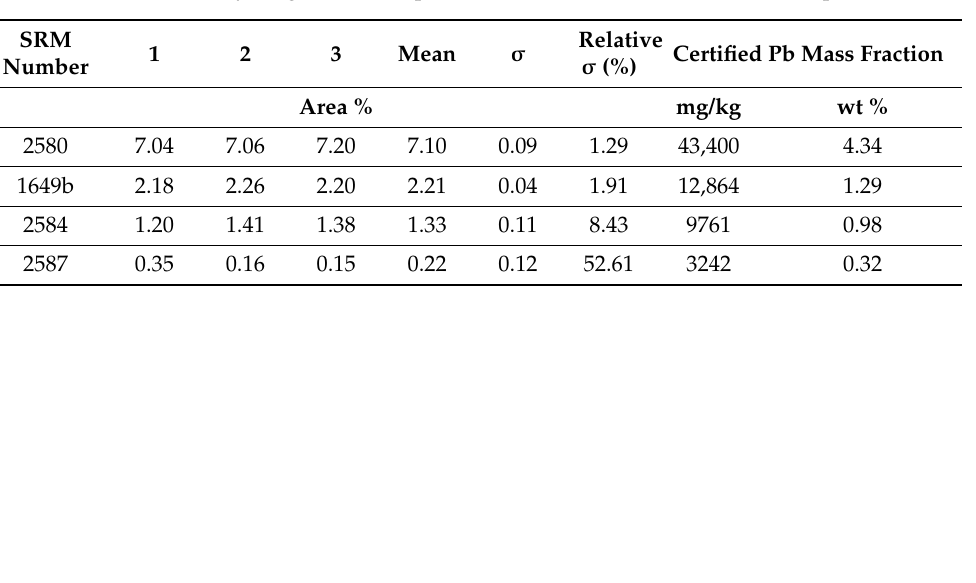
Table 3. Summarised PARC results for NIST SRMs, showing Pb-rich phase abundance as silhouette area fraction (as %) of total analysed grain surface per measurement. Relative σ = σ /mean, reported as